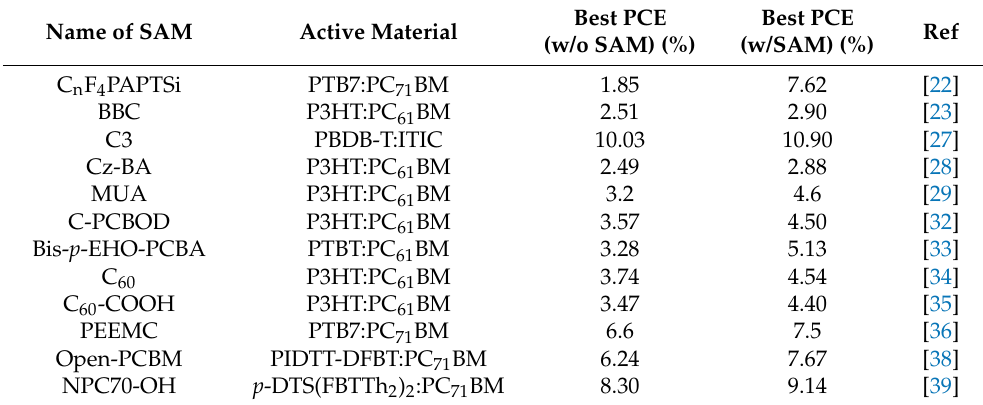
Table 1. Previous reports on performance enhancement of organic solar cells by